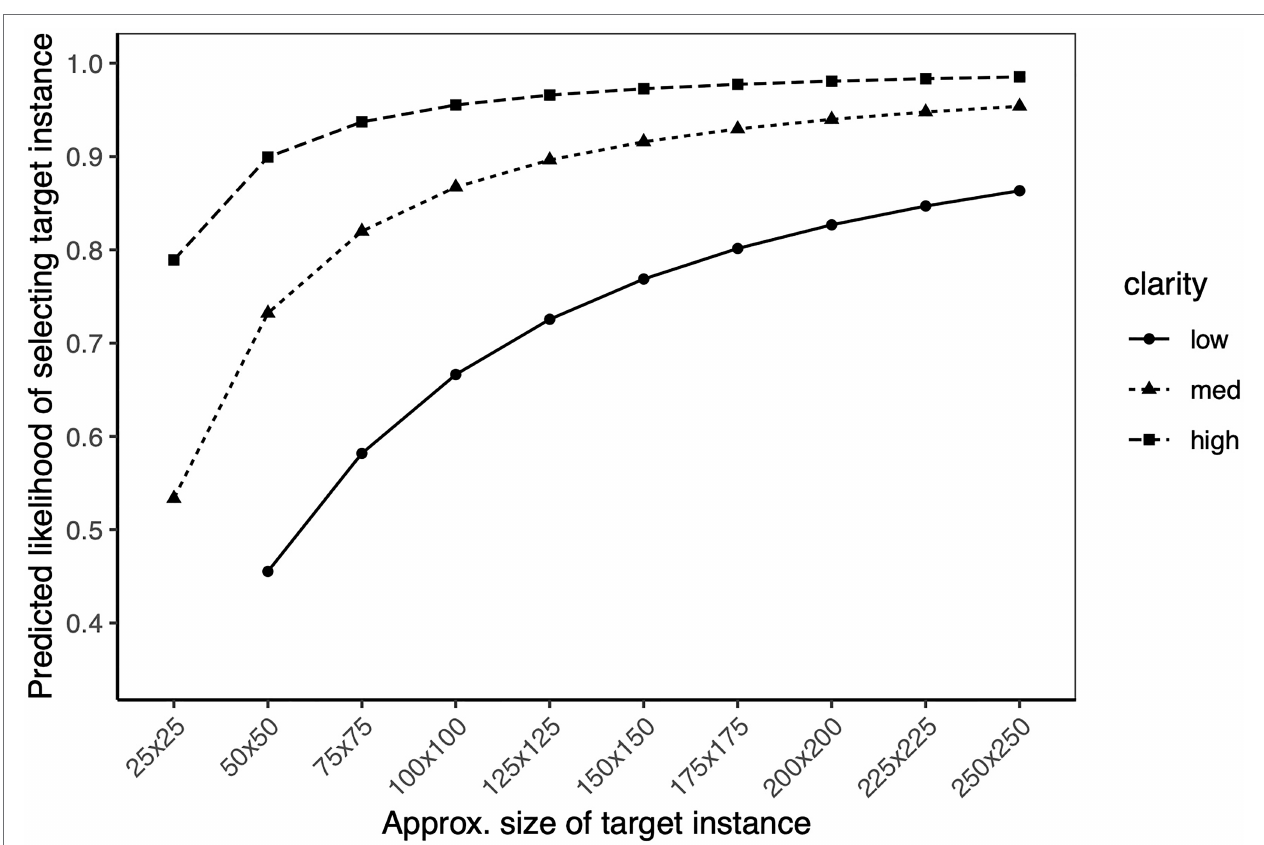
FIGURE 7 | Likelihood of identifying target instance, by size and clarity.